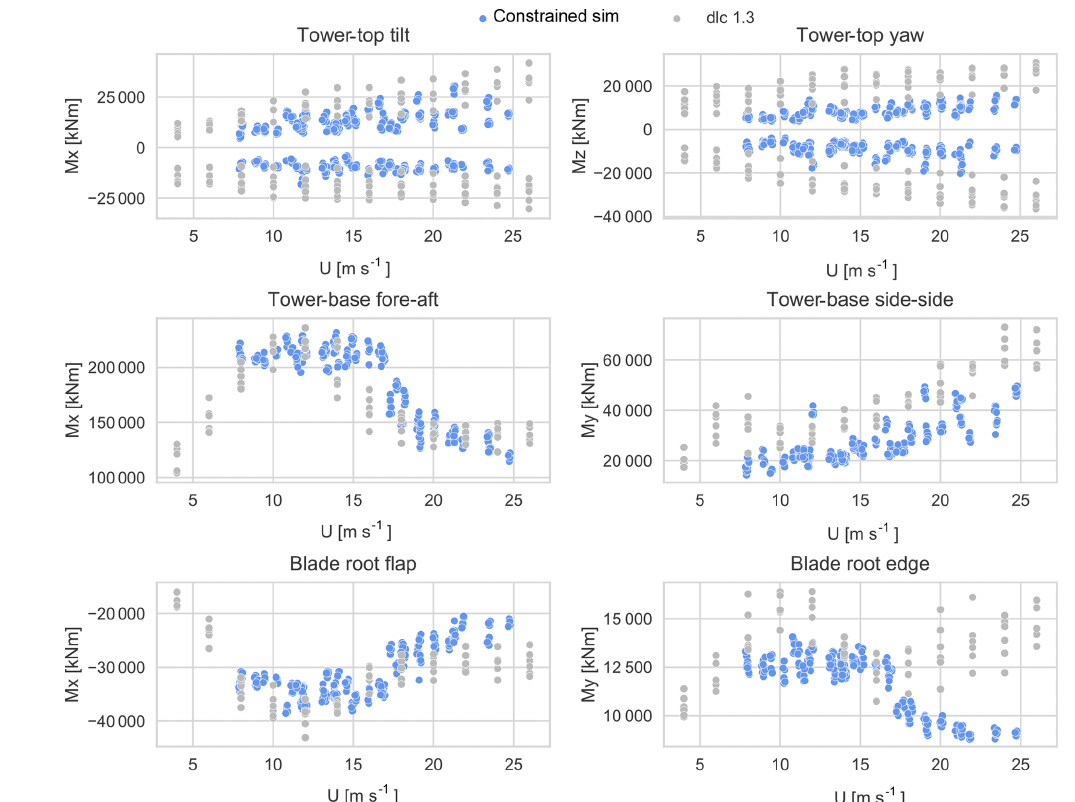
Figure B1. The extreme moments from IEC DLC 1.3 (grey dots) and the extreme loads from the constrained simulations (blue dots).